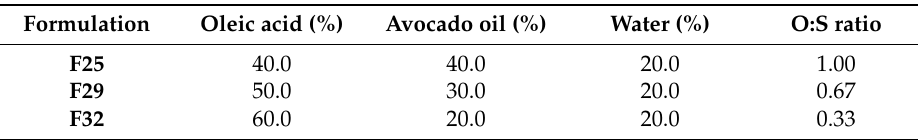
Table 1. Percentages of components of the